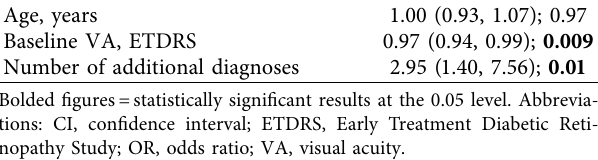
Table 4: Multiple logistic regression for predictive factors of worse final visual acuity following intraocular foreign body extraction in 54 patients.